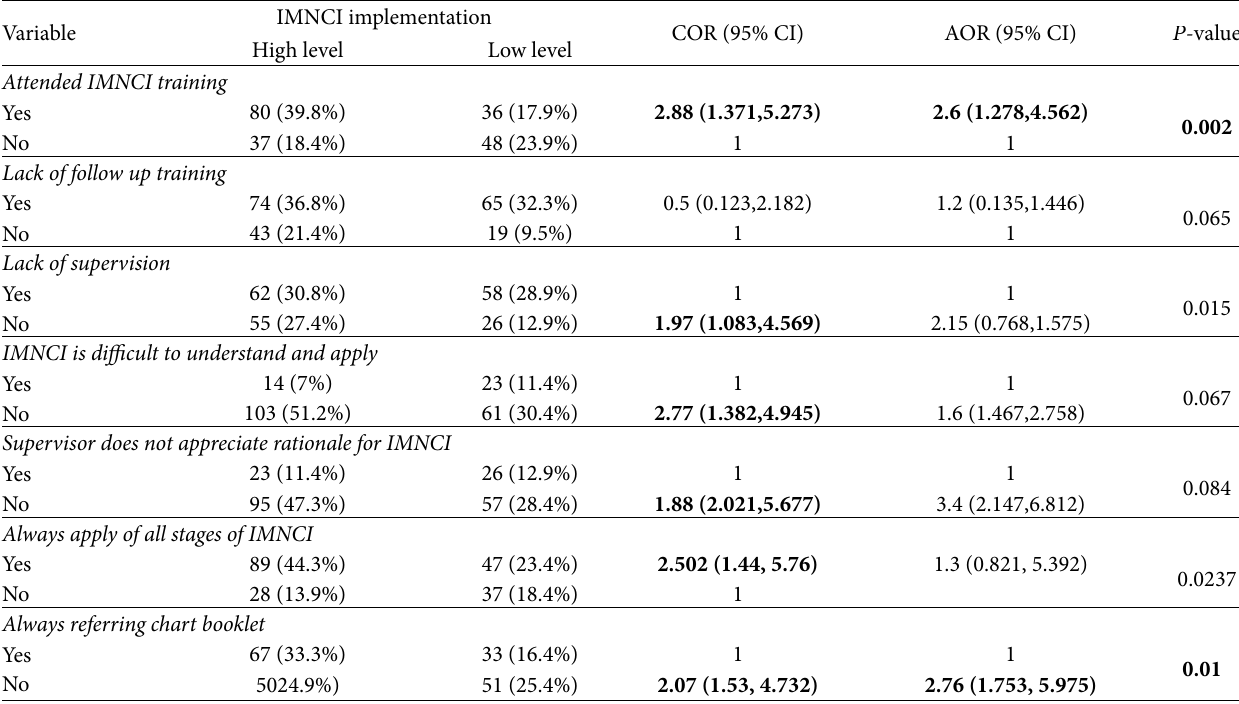
Table 17: Association of factor influencing IMNCI implementation by health care professionals adjusted to confounding variables in Yifat cluster in North Shewa zone, April 2016 ( 𝑛 = 201